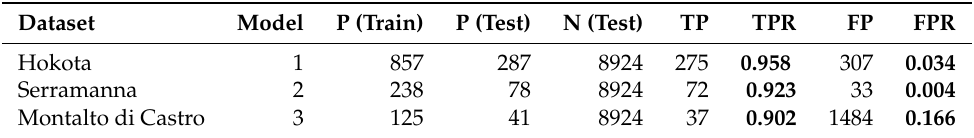
Table 2. Experiment 1: True positive rate (TPR) and false positive rate (FPR) for hotspot detection in thermal images. The R-CNN model was trained using one dataset and evaluated on a disjoint subset of the same